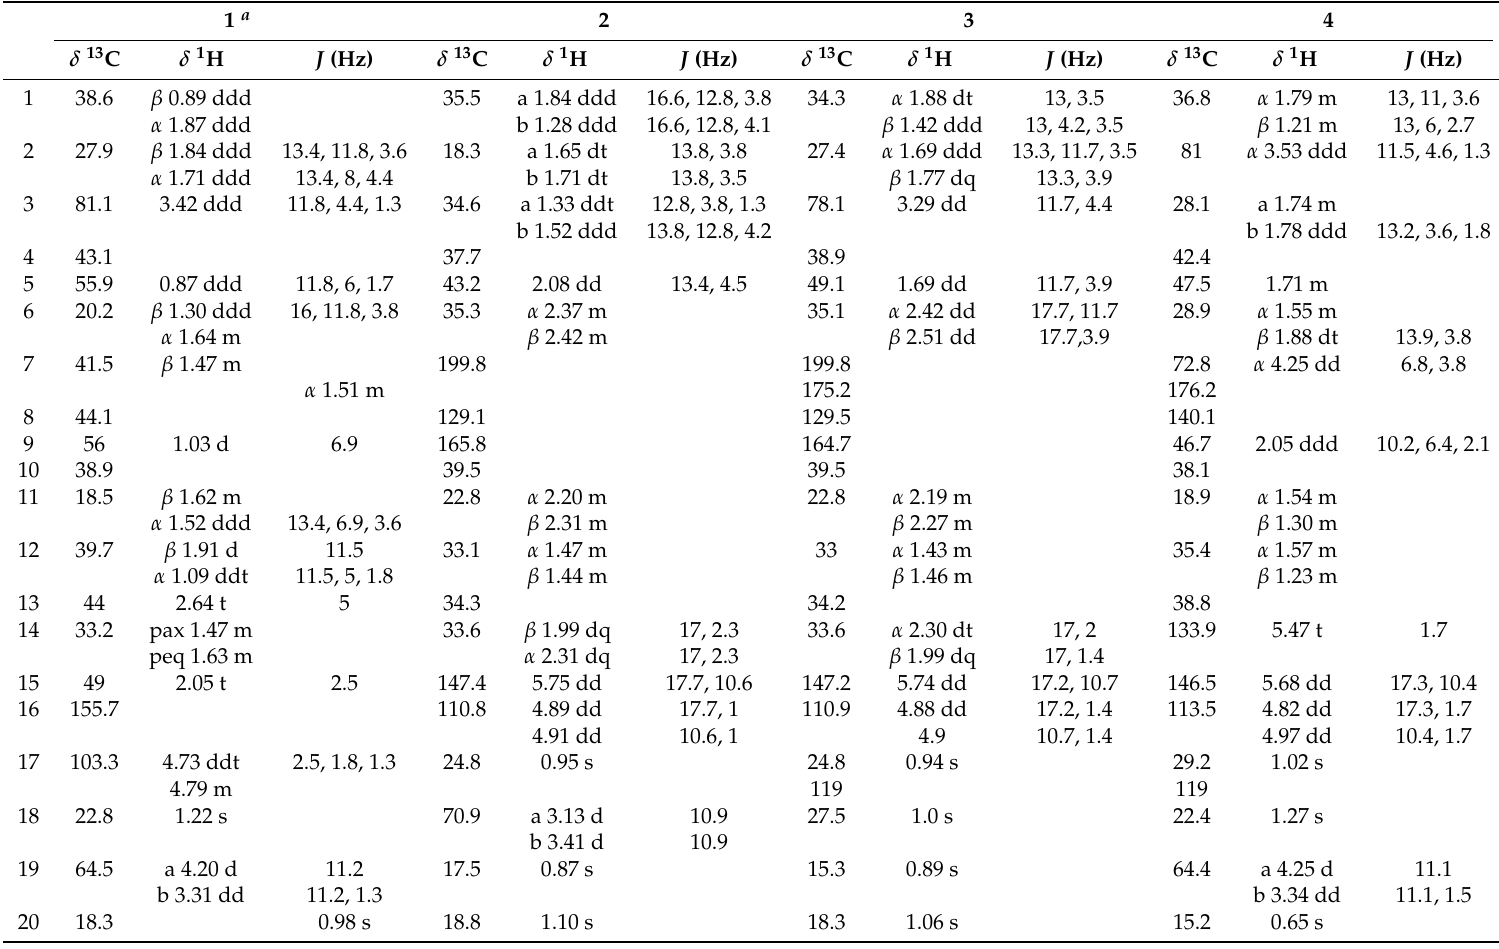
Table 2. 13 C-NMR and 1 H-NMR spectroscopic data for 1 – 4 (150 and 600 MHz, CDCl 3